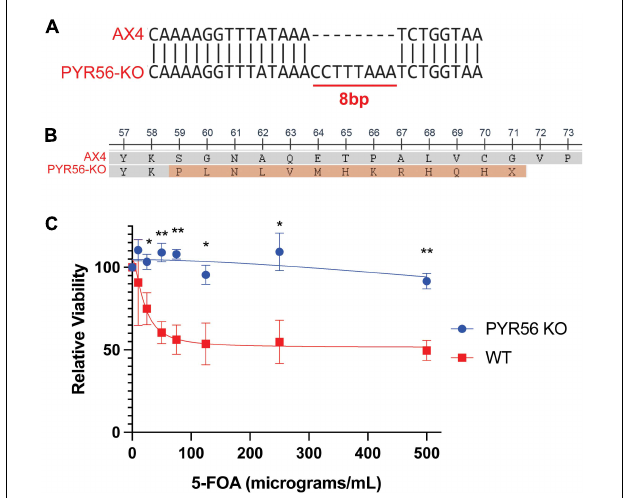
FIGURE 2 | Deletion of pyr56 confers resistance to 5-FOA toxicity. (A) The pyr56- KO generated by CRISPR-Cas9 contains an 8 bp insertion in the Pyr56 gene. (B) The 8 bp insertion in the Pyr56 gene results in a frameshift after amino acid residue 58 and a premature stop after residue 71. (C) Deletion of pyr56 results in survival when cells are grown in media containing 5-FOA. Either wild-type or pyr56- KO Dictyostelium at a starting concentration of 5 × 10 3 cells/mL were grown in presence of increasing concentrations of 5-FOA. Viability was measured by luminescence using the CellTiter-Glo Viability Assay at 48 h ( n = 3). Samples were analyzed for statistical significance using an unpaired t -test, * p < 0.05. ** p <